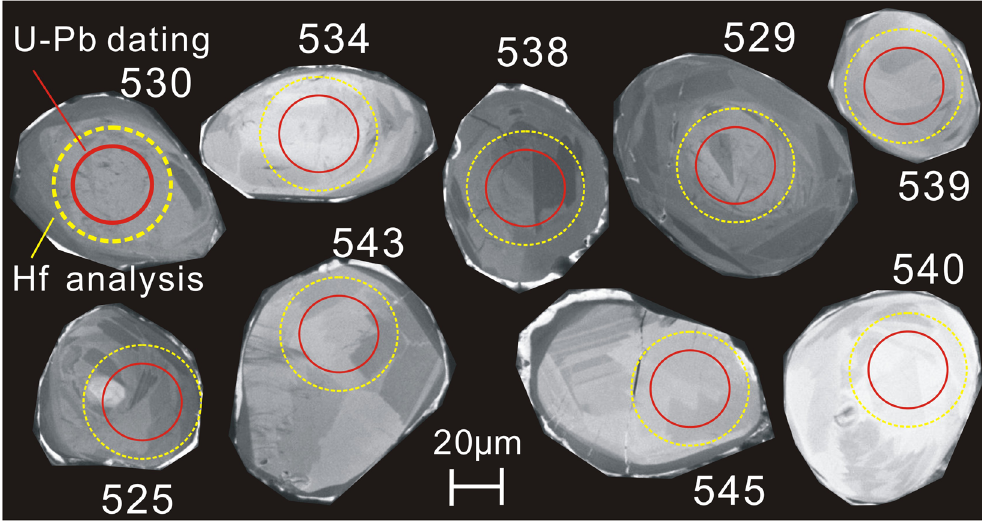
Figure 3. Representative CL images of analyzed zircons from the